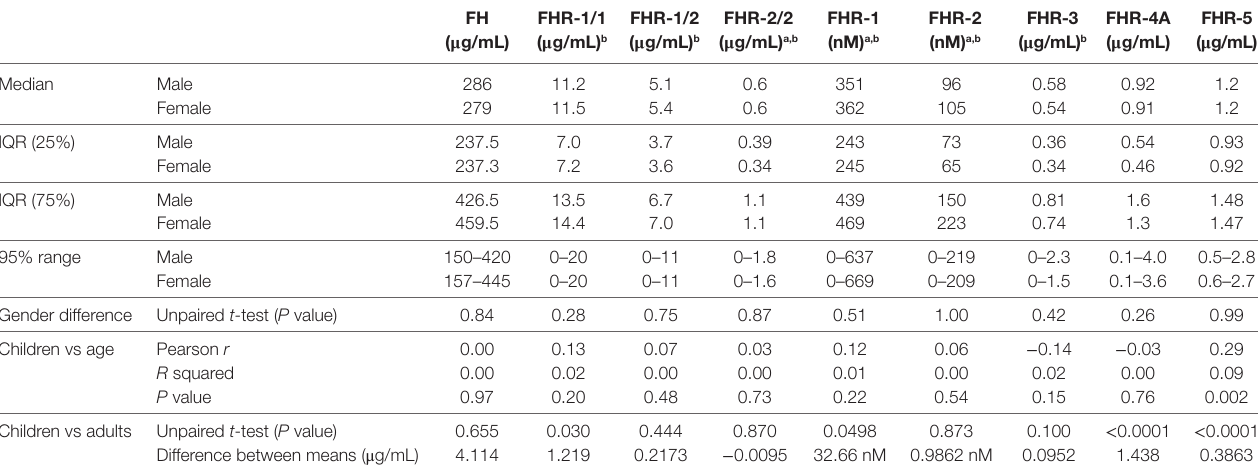
Table 2 | Factor H (FH) family normal ranges